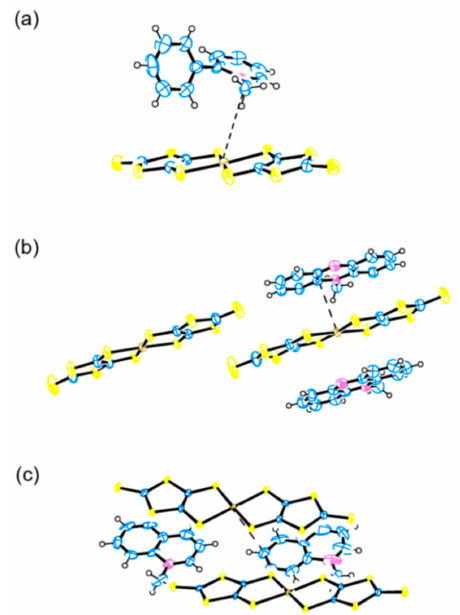
Figure 20. Typical molecular arrangements of anions and cations in ( a ) M2Pp[Au(dmit) 2 ], ( b ) NMP[Au(dmit) 2 ], and ( c ) NMQ[Au(dmit) 2 ]. For M2Pp + , NMP + , and NMQ + , see Figure 18. Blue, purple, blank, yellow, and brown spheres designate C, N, H, S, and Au atoms, respectively. The broken lines indicate the Au–C N distances; ( a ) 4.40(1), ( b ) 3.584(4), and ( c ) 3.726(6) Å. The dihedral angle between the two aromatic rings in the M2Pp + cation in ( a ) is 58.6(16) ◦ , while the NMP + and NMQ + cations and all the [Au(dmit) 2 ] − anions are almost perfectly planar. Details are deposited to Cambridge Crystallographic Data Centre; the CCDC # are ( a ) 2032445, ( b ) 2032448, and ( c )